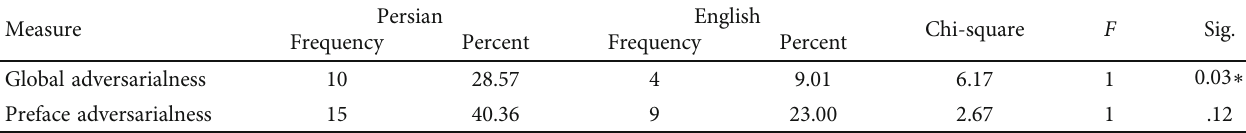
Table 6: The frequency distribution of content adversarialness in English and Persian. Measure